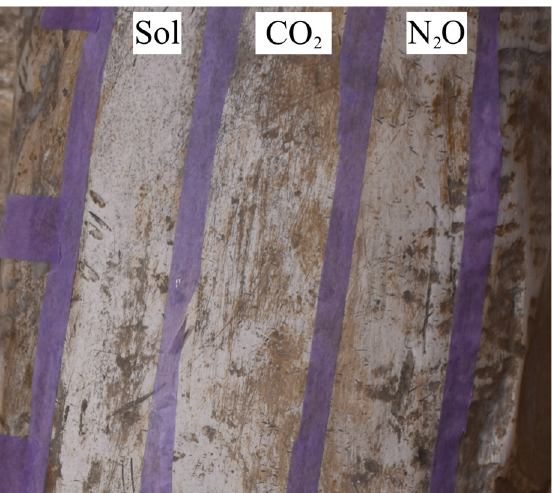
Figure 9. Image after cleaning procedure with agar sol, agar CO 2 foam and agar N 2 O foam on the cast of the Pietà Rondanini.